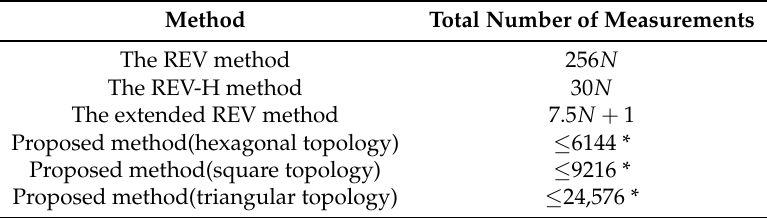
Figure 16. Comparison of the total number of measurements between the REV method, the REV-H method, the extended REV method and the proposed method with different topologies. Table 6. Comparison of total number of measurements of a large array with N antennas by different